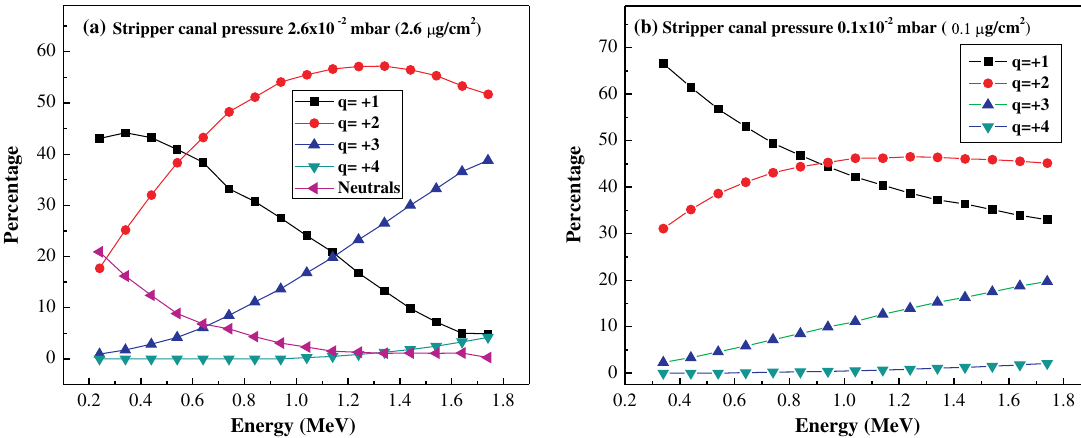
FIG. 5. (a) Variation of percentage of charge states fractions with the incident ion energy at the stripper gas pressure of 2 : 6 (cid:3) 10 (cid:1) 2 mbar . The neutrals were estimated from the mismatch between the experimental and the empirical value of the average charge. (b) Variation of percentage of charge state fractions at 0 : 1 (cid:3) 10 (cid:1) 2 mbar stripper gas